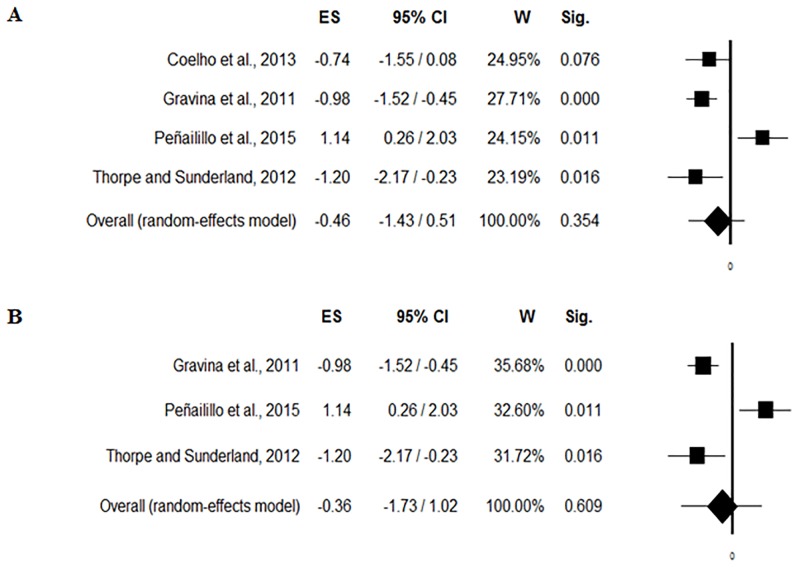
Forest plot of testosterone [nmol/L] changes induced by soccer match, including (4a) and removing (4b) Coelho et al. [29].